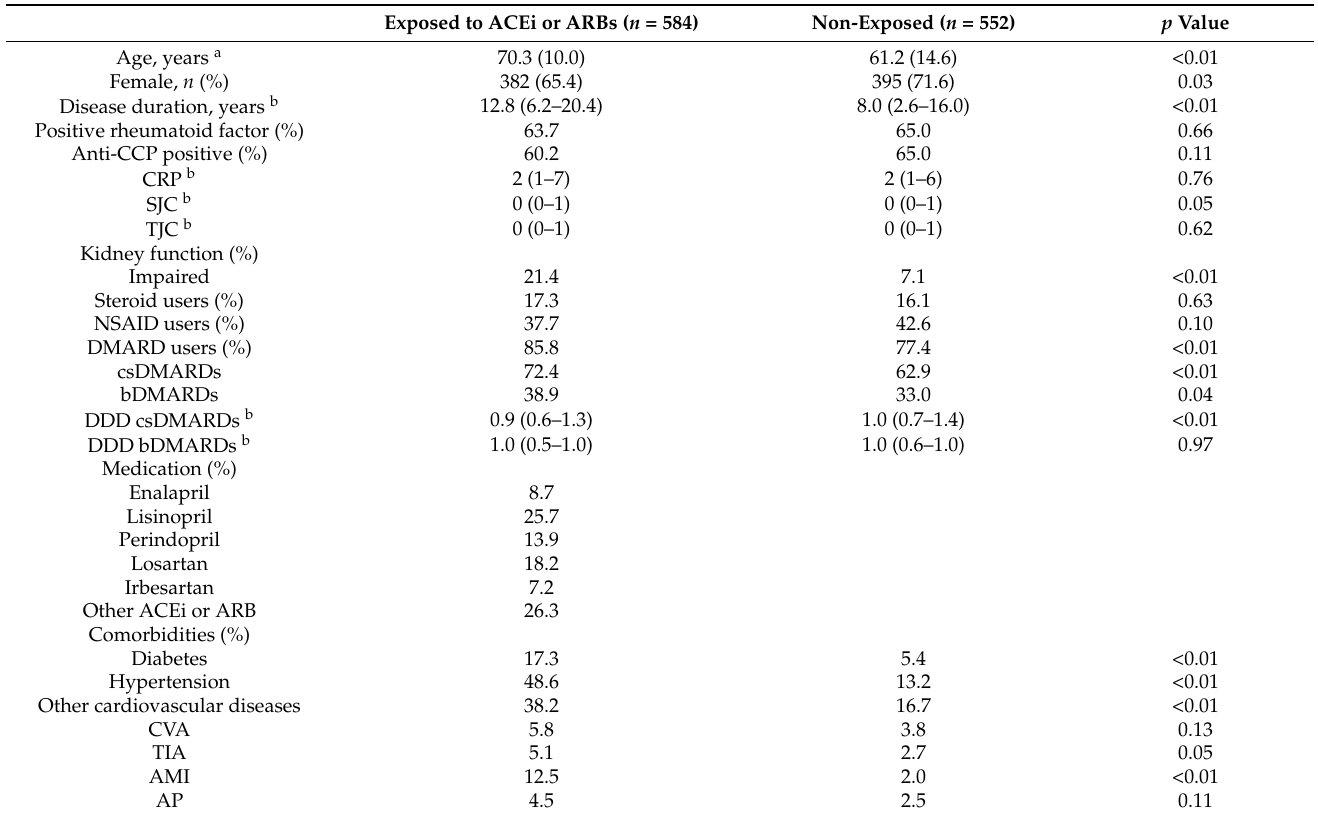
Table 1. Demographic variables and patient